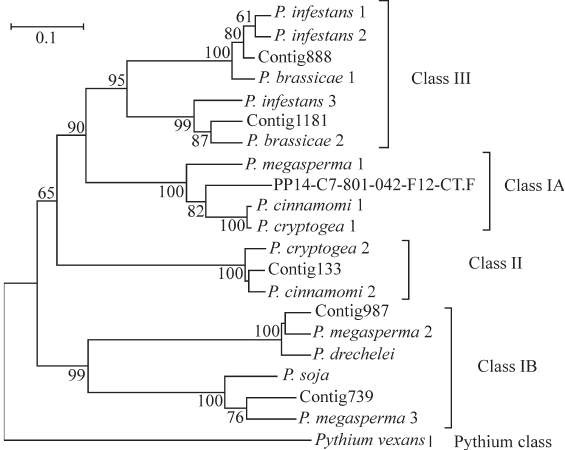
Figure 4 - Phylogenetic dendrogram of elicitin amino acid sequences. Multiple alignment of selected elicitin amino acid sequences from